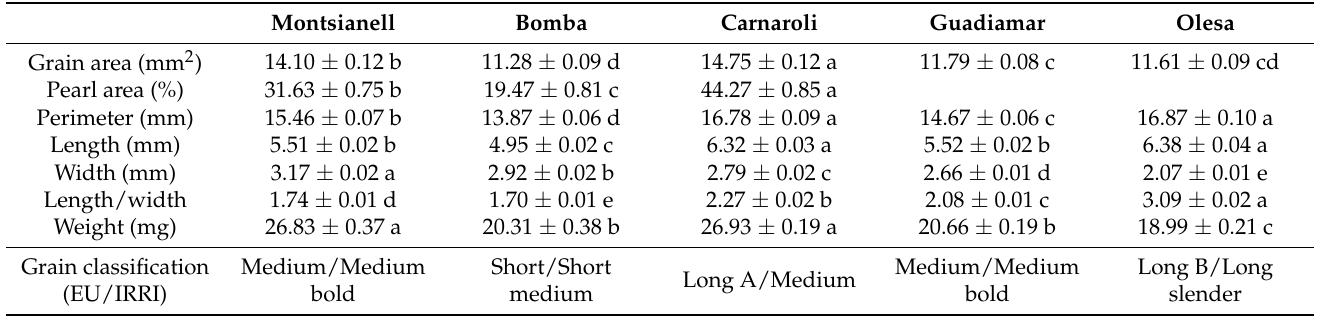
Table 1. Physical parameters of the cultivars studied, presented as mean ± SEM. Different letters associated with a measurement indicate significant differences ( p <